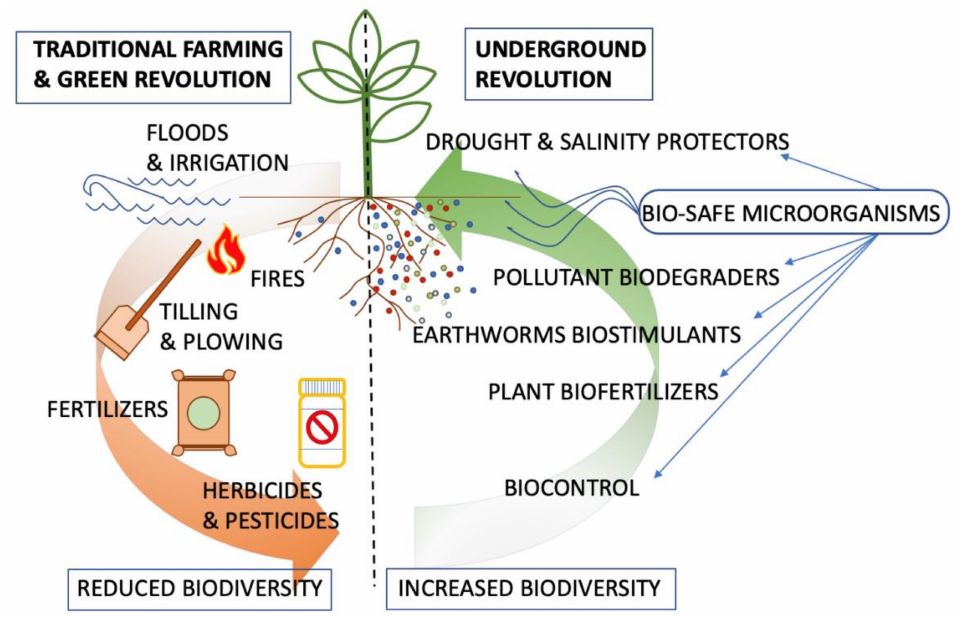
Figure 1. Conceptual diagram of traditional farming and Green Revolution, and Underground Revolution on soil microbial biodiversity. Colored dots represent microbial